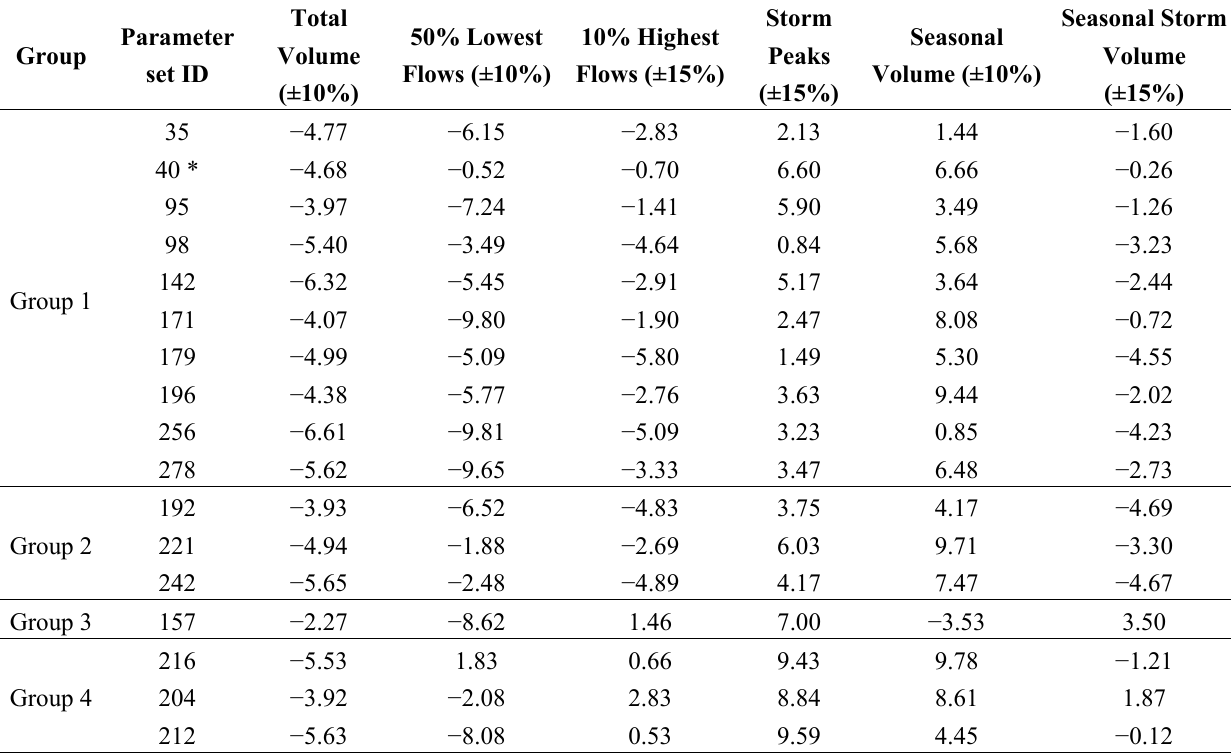
Table 6. The HSPEXP criteria values of Groups 1 to 4 (for the Reed Creek watershed). Group